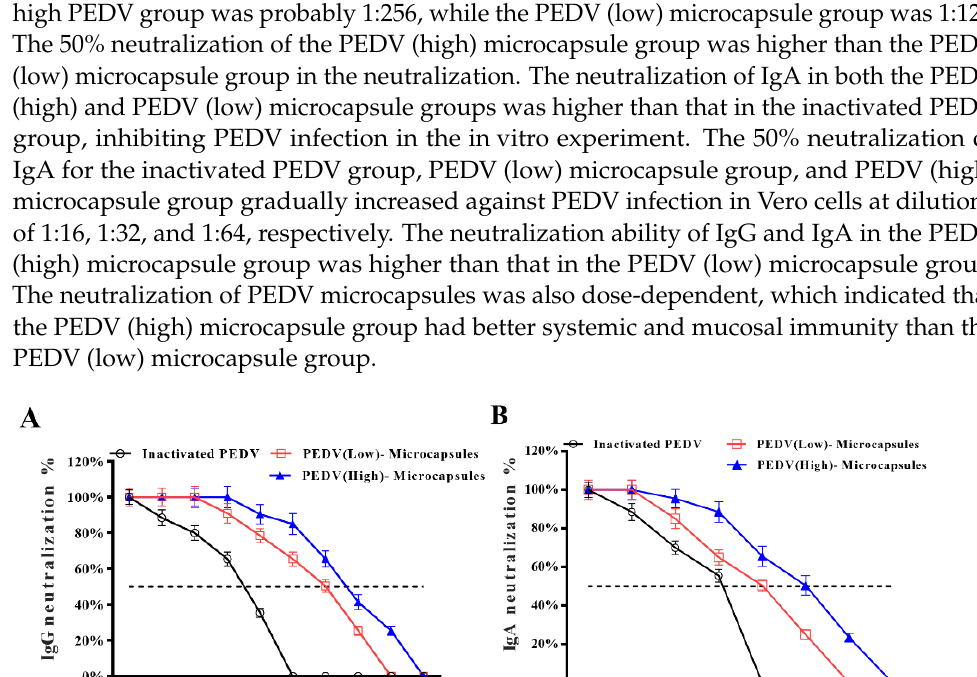
Figure 2. Enzyme-linked immunosorbent assay measures of antibodies IgA and IgG in feces ( A ) and serum ( B ) after the final immunity. The differences between means were considered significant at * p < 0.05 and very significant at ** p < 0.01.